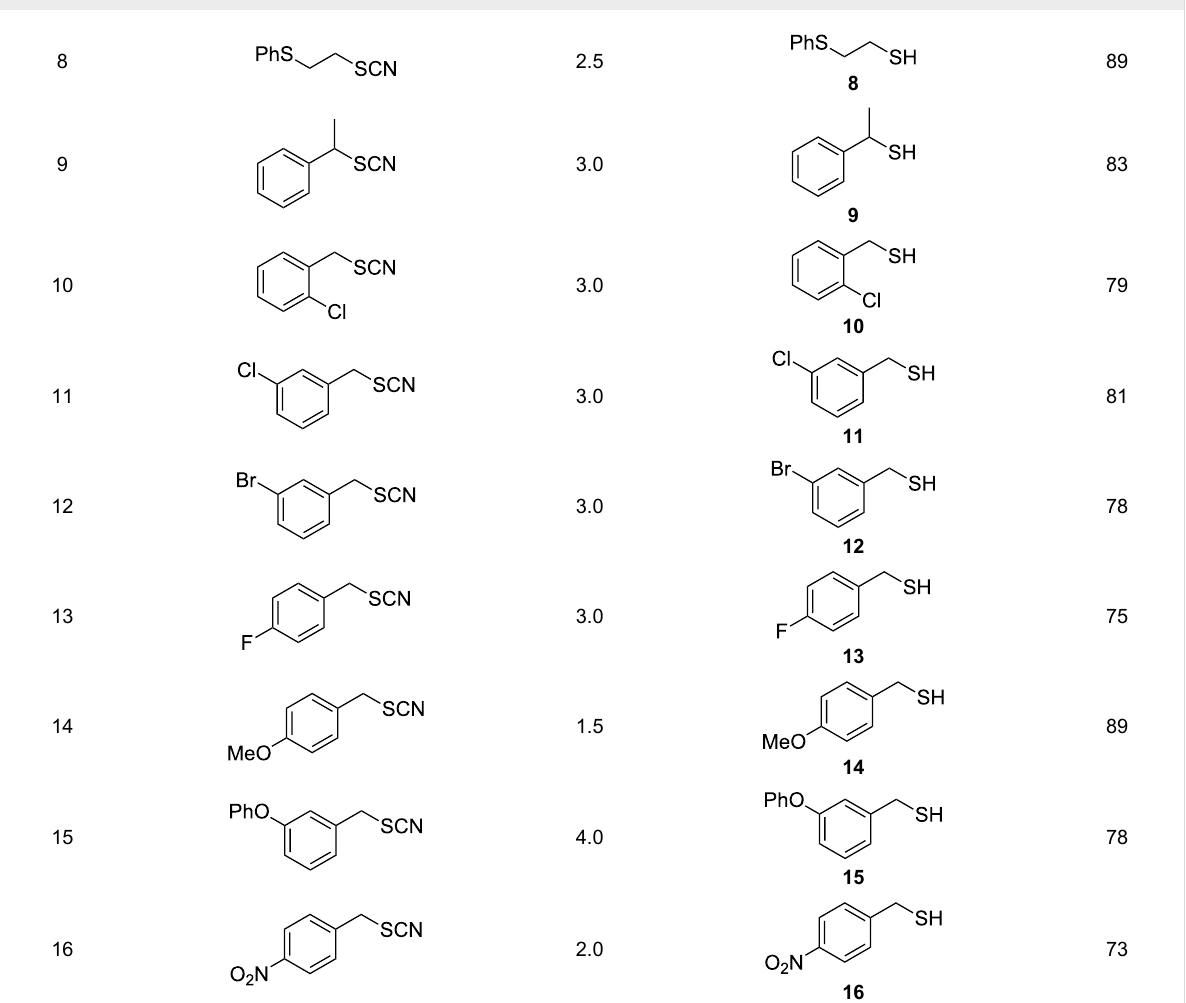
Table 2: Conversion of different thiocyanates to thiols with P 2 S 5 in refluxing toluene a . (continued)